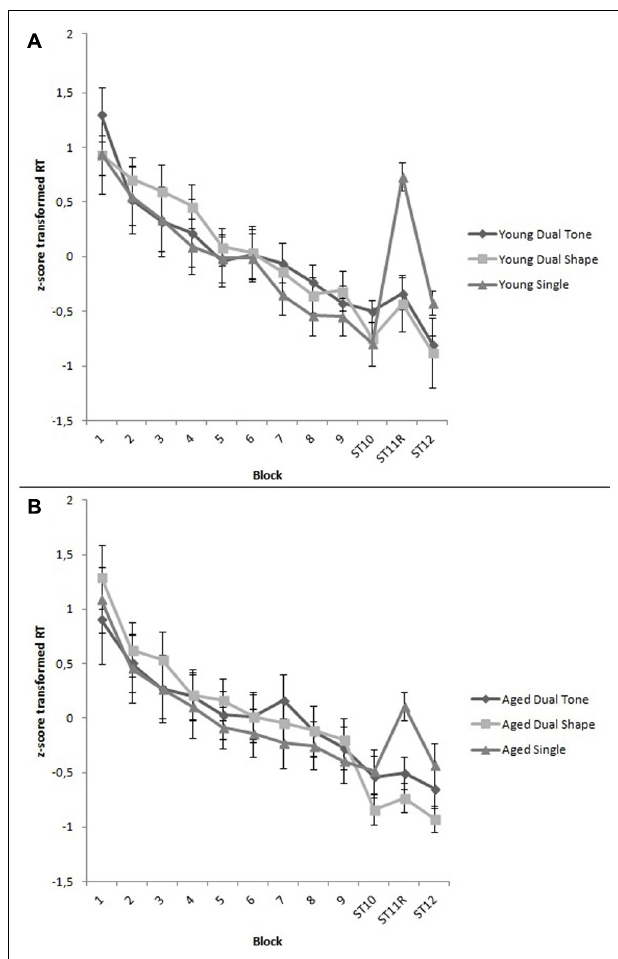
FIGURE 1 | (A) z-score transformed RTs per block for young adults under single, dual tone and dual shape conditions. All blocks are structured, except for random Block 11. During the first nine blocks, a secondary counting task was presented in the dual tone and dual shape conditions. Vertical bars denote standard errors. (B) z-score transformed RTs per block for aged adults under single, dual tone and dual shape conditions. All blocks are structured, except for random Block 11. During the first nine blocks, a secondary counting task was presented in the dual tone and dual shape conditions.Vertical bars denote standard